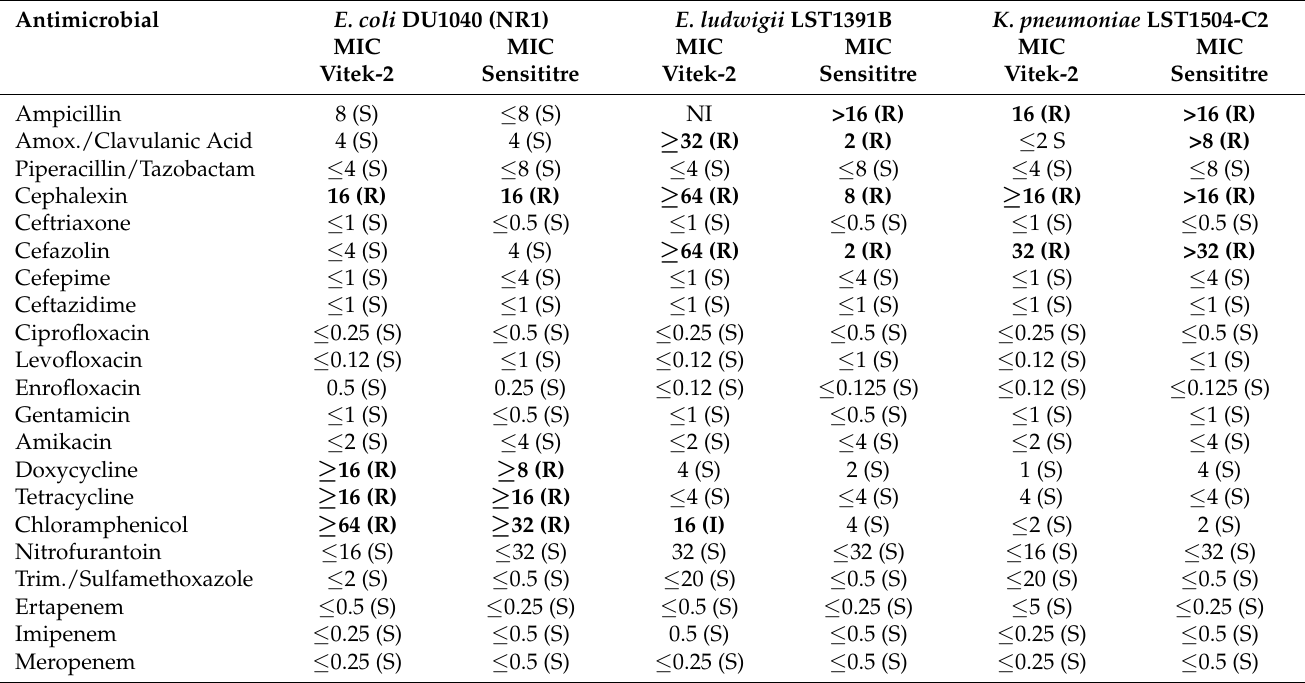
Table 3. Minimum inhibitory concentration (MIC) of antimicrobials for the standard and two test strains using two methods, Sensititre and Vitek-2.